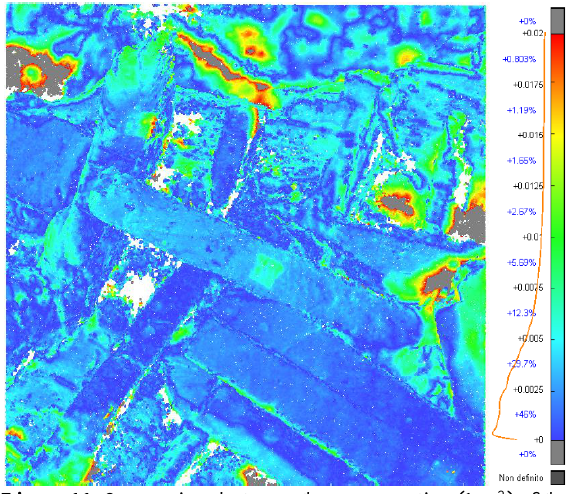
Figure 11 . Comparison between the same portion (1 m 2 ) of the two dense point clouds generated in the two days of the underwater photogrammetric survey using the two different georeferentiation